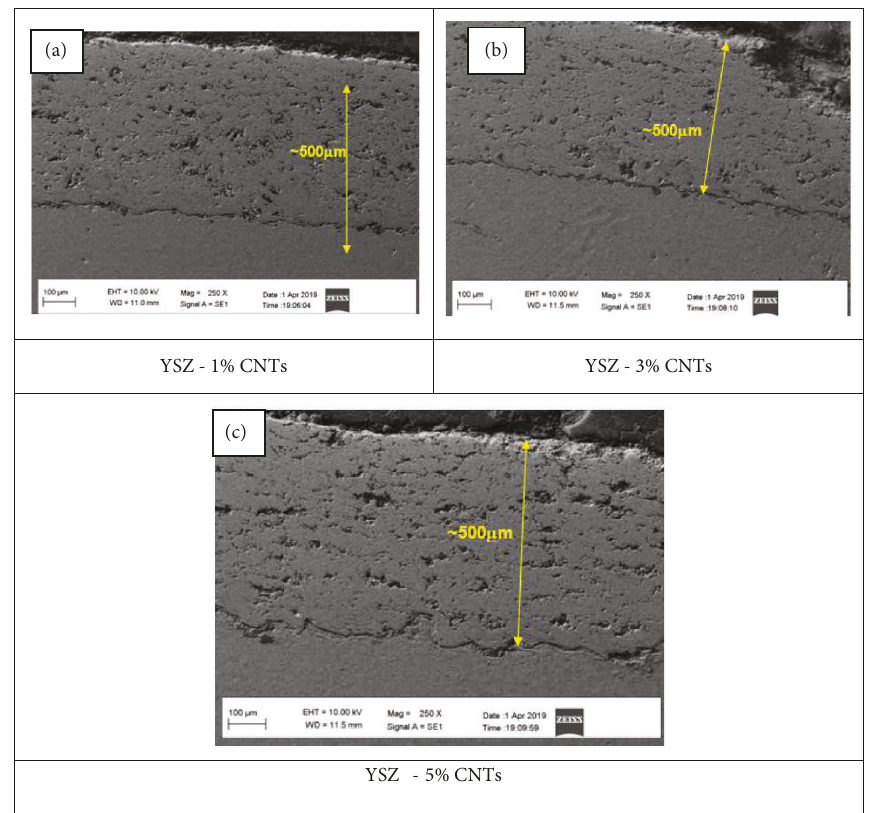
Figure 5: SEM image of YSZ coating with different percentage of CNT indicating the thickness of the coating. (a) YSZ-1% CNTs. (b) YSZ- 3% CNTs. (c) YSZ-5% CNTs.